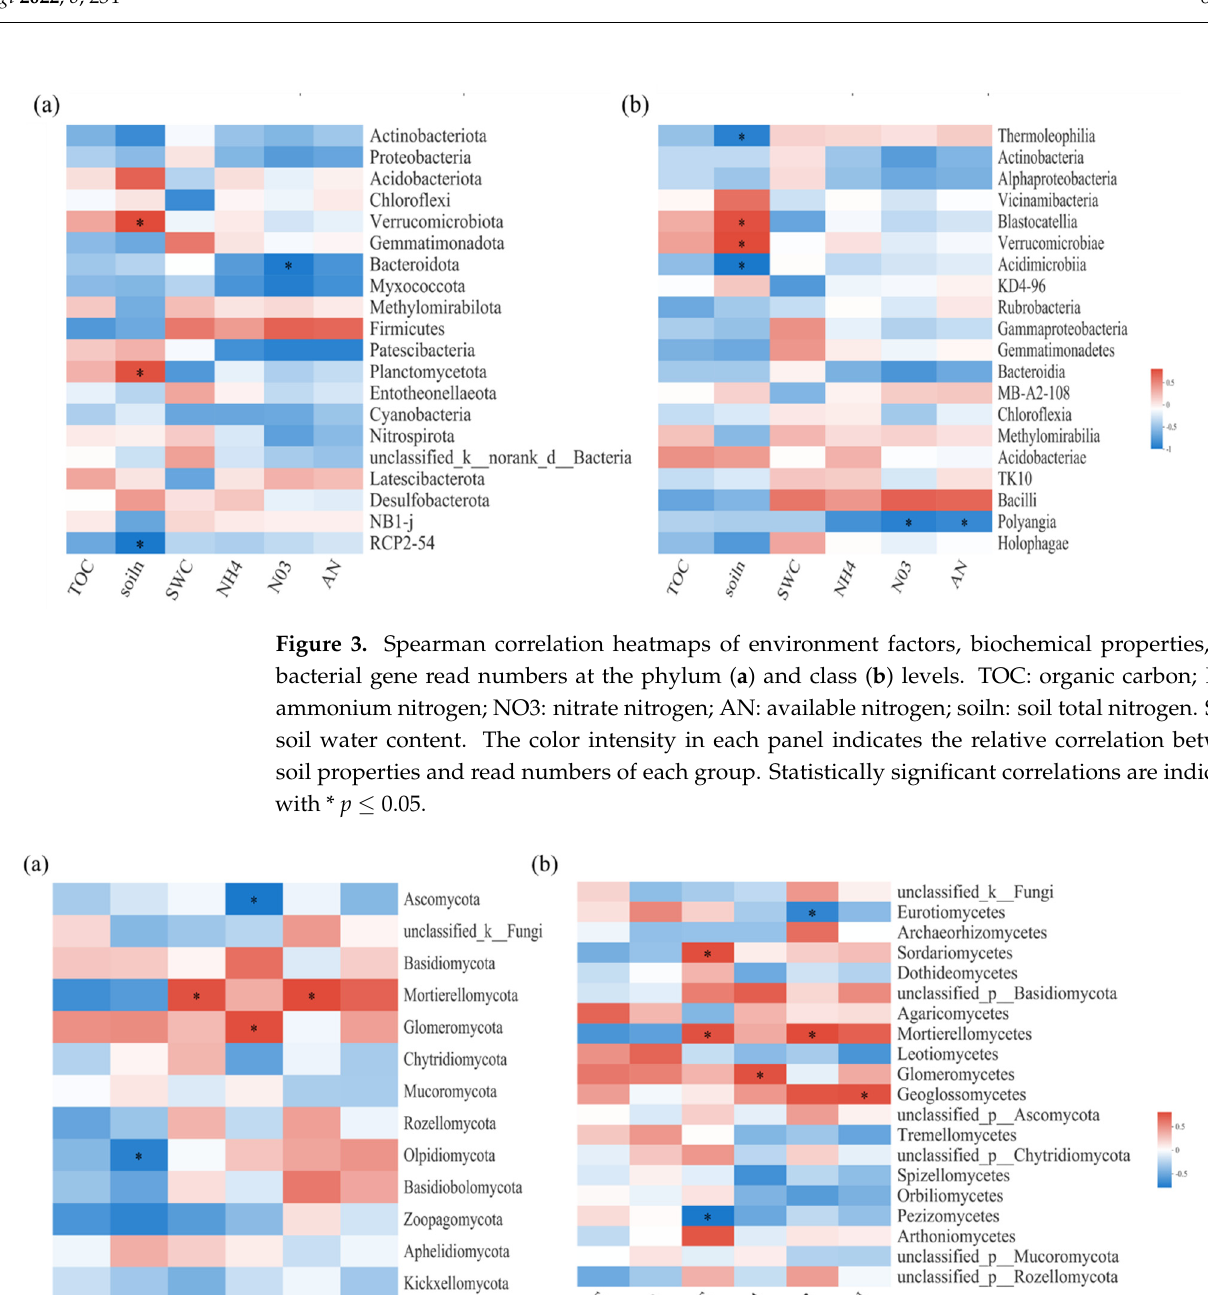
Figure 4. Spearman correlation heatmaps of environment factors, biochemical properties, and fun- gal gene read numbers at the phylum ( a ) and class ( b ) levels. TOC: organic carbon; NH4: ammonium nitrogen; NO3: nitrate nitrogen; AN: available nitrogen; soiln: total nitrogen. SWC: soil water con- tent. The color intensity in each panel indicates the relative correlation between soil properties and read numbers of each group. Statistically significant correlations are indicated with * p ≤ 0.05.